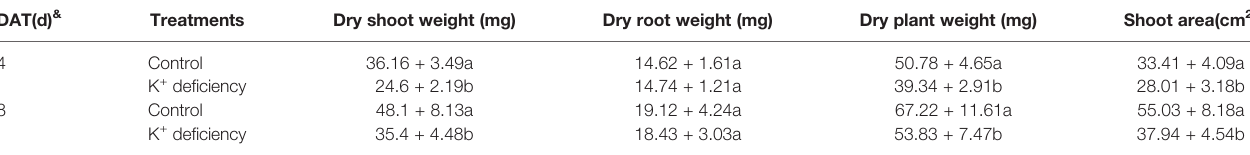
TABLE 1 | Effect of K + de fi ciency on plant biomass of wheat seedlings and shoot area at 4/8 days after transfer day (DAT)*. DAT(d) &